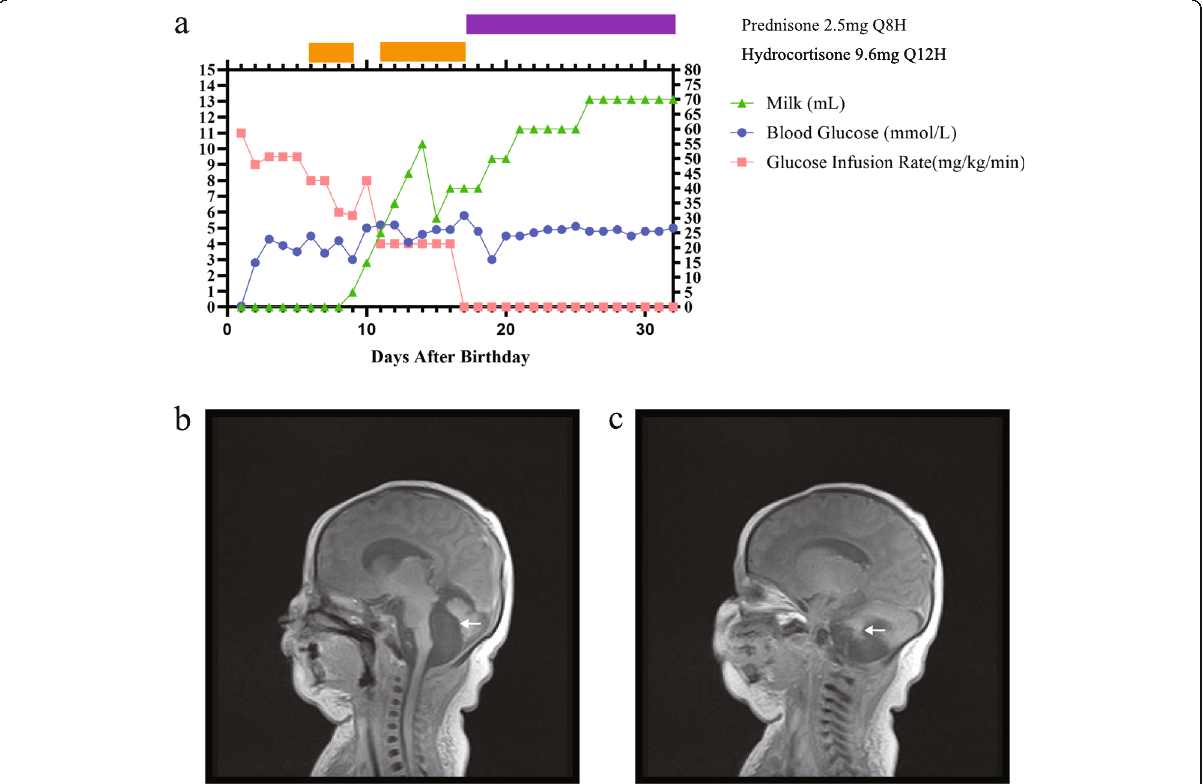
Fig. 1 The clinical features of the patient. a Blood glucose (mmol/L, left Y axis), glucose infusion rate (mg/kg/min, left Y axis) milk (mL, right Y axis), and medical treatment during the first month in the NICU. b Magnetic resonance image of cystic enlargement of the fourth ventricle (arrow). c Magnetic resonance image of hypoplasia of the cerebellar vermis